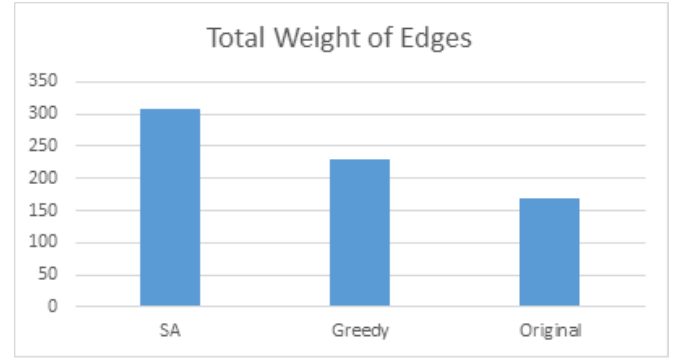
Figure 10. Comparing total distances among hotspots for different algorithms.